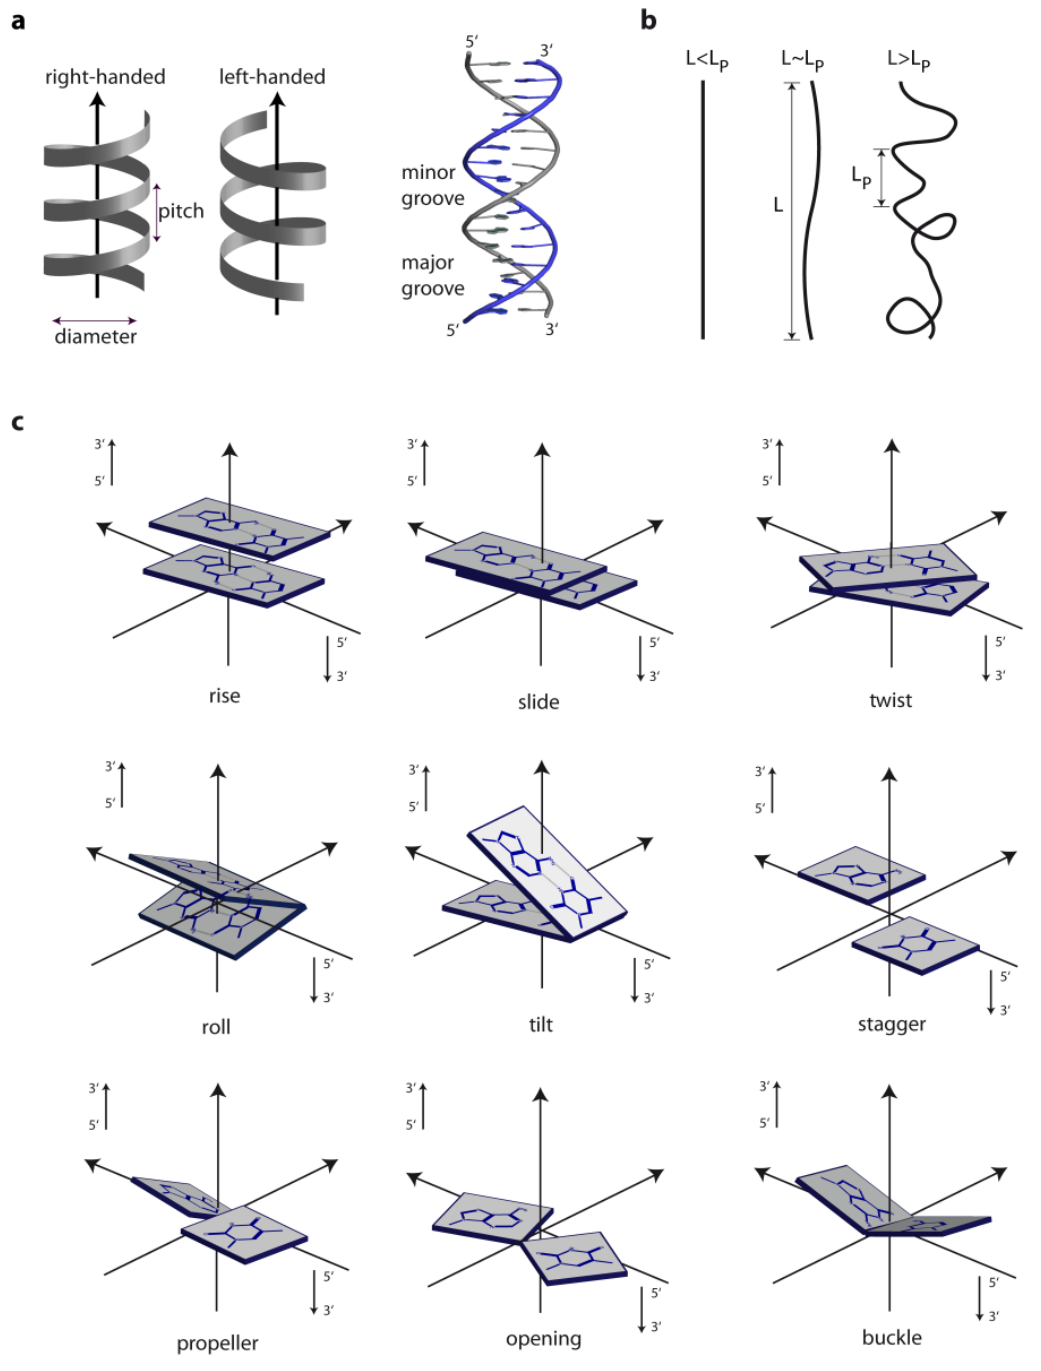
Figure 1. Geometric and physical parameters of DNA. ( a ) Helix parameters; ( b ) The persistence length (L ) provides a measure of the rigidity of a linear polymer and is P determined by the change in orientation of a polymer backbone as its chain contour is traversed. A greater chain conformational freedom is reflected by a shorter persistence length; ( c ) Examples for geometric parameters defining the location and orientation of the base pair steps